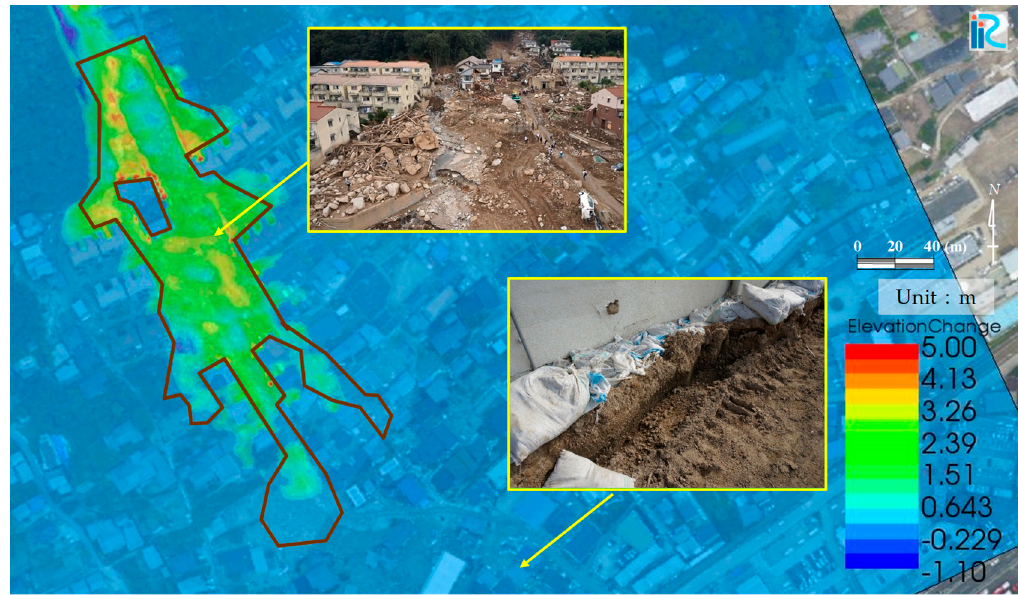
Figure 14. Horizontal distribution of the land deformation thickness in the residential area obtained by the numerical analysis. The brown line indicates the region where large rocks and driftwoods are inundated.